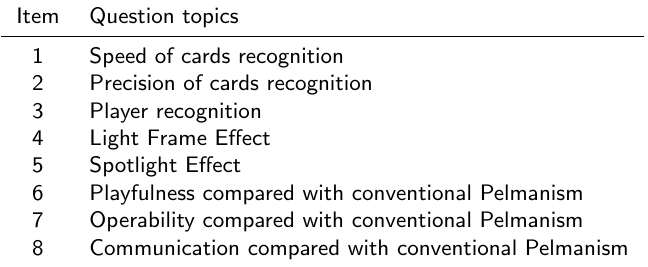
Table 4. Questionnaires to evaluate the prototype system